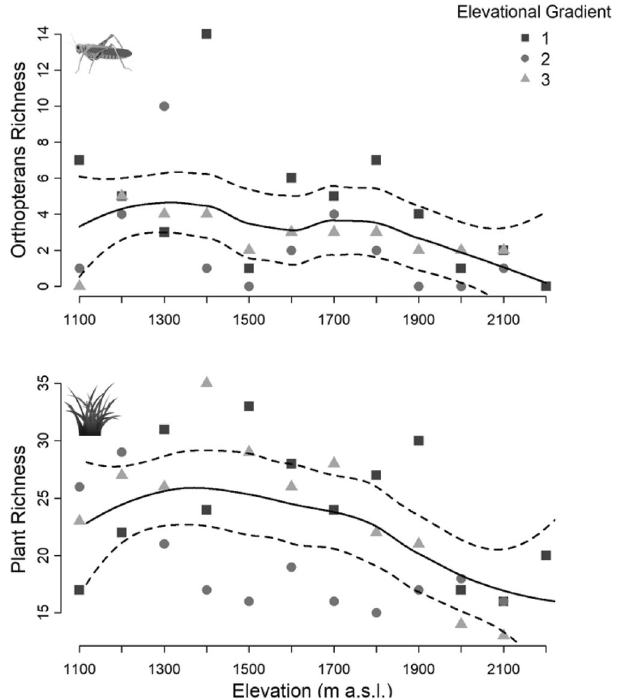
Figure 2. Elevational pattern of orthoptera and plant richness for each of the elevational gradients. The line is a local regression model for the three elevational gradients together with a 95% confidence interval. Spearman correlation: r = 0.37, p = 0.03. Figure generated using R software 23 .